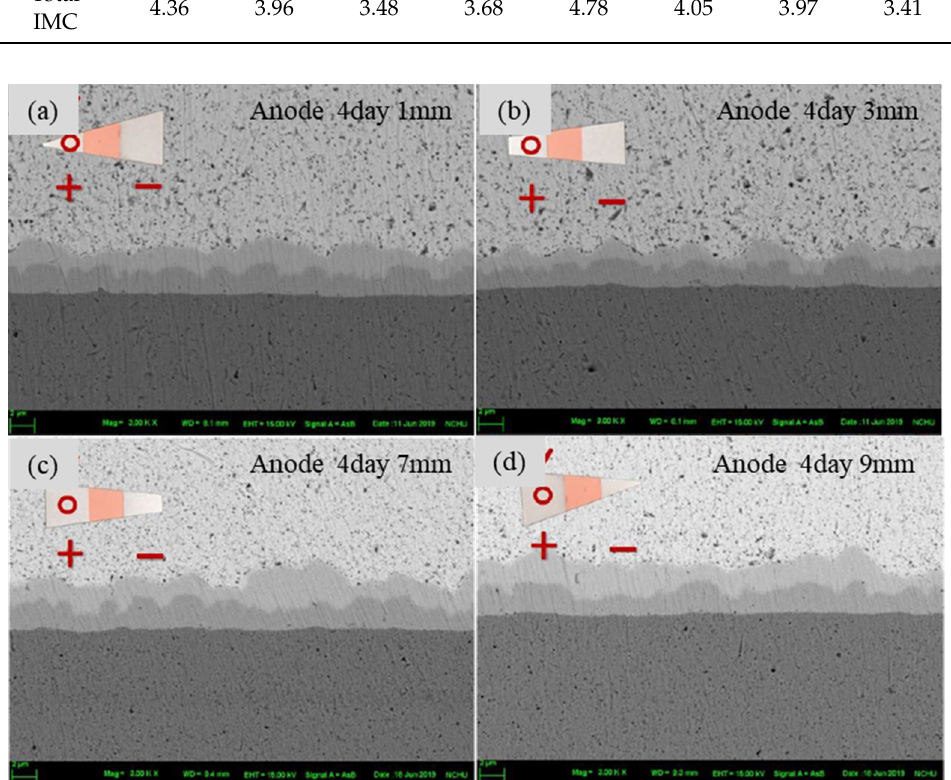
Figure 11. SEM images of various samples heated at 130 °C and subjected to a current of 0.8 A after 4 days. ( a ) Anode ends (indicated on red circle) on the 1mm side of 1:9 sample; ( b ) Anode ends (indicated on red circle) on the 3mm side of 3:7 sample; ( c ) Anode ends (indicated on red circle) on the 7mm side of 3:7 sample; ( d ) Anode ends (indicated on red circle) on the 9mm side of 1:9 sample.